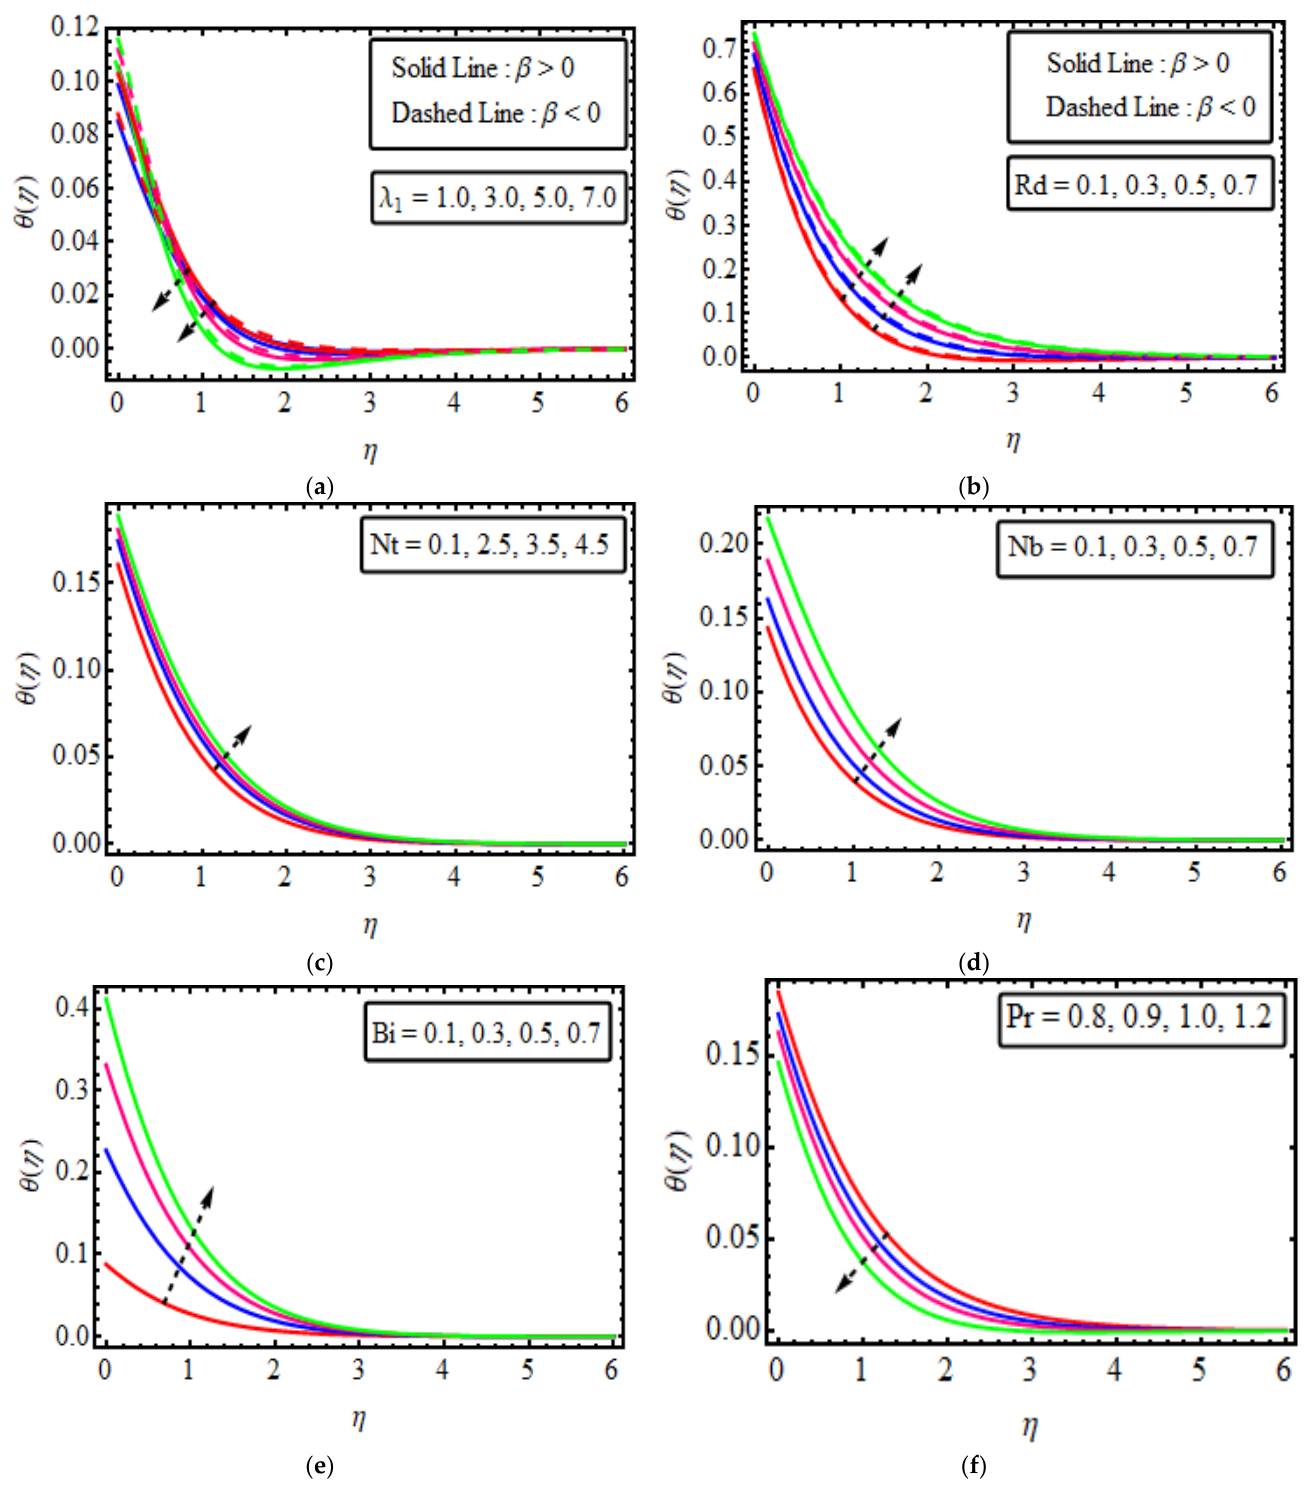
Figure 4. ( a – f ). The impact of 𝜃(cid:4666)𝜂(cid:4667) numerous variables ( a ) 𝜆 (cid:2869) ( b ) 𝑅𝑑 ( c ) 𝑁𝑡 ( d ) 𝑁𝑏 ( e ) 𝐵𝑖 ( f ) 𝑃𝑟